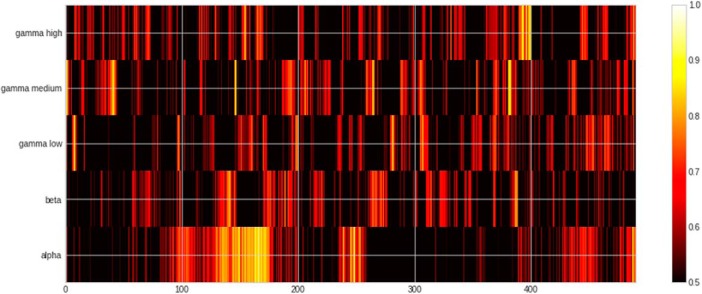
Heatmap of ROC-AUC scores for all bands in semantic condition.